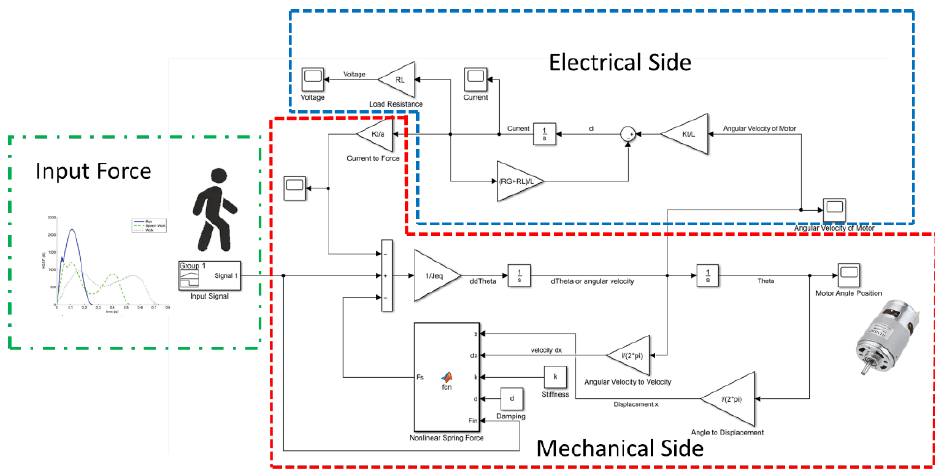
Figure 7. Simulink model for the electromagnetic (EM) generator with lead-screw design.